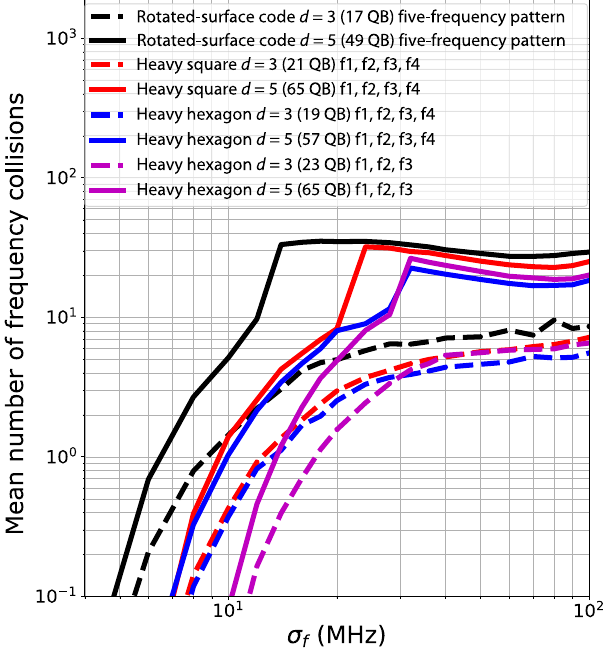
FIG. 11. Monte Carlo simulations of the collision rate due to qubit frequency scatter caused by fabrication imprecision. Averages of > 10 3 Monte Carlo repetitions. The x axis is the frequency precision of the fabrication σ (MHz). The y axis is the f mean number of collisions for each device for each value of σ . f Heavy-hexagon code using the three-frequency design in the right panel of Fig. 10(a): d ¼ 3 (magenta dashed line) and d ¼ 5 (magenta solid line). Heavy-hexagon code using the four-fre- quency design in the left panel of Fig. 10(a): d ¼ 3 (blue dashed line) and d ¼ 5 (blue solid line). Heavy-square code using the four-frequency design in the left panel of Fig. 10(b): d ¼ 3 (red dashed line) and d ¼ 5 (red solid line). Rotated-surface code, degree-four, and five-frequency pattern: d ¼ 3 (black dashed line); d ¼ 5 (black solid